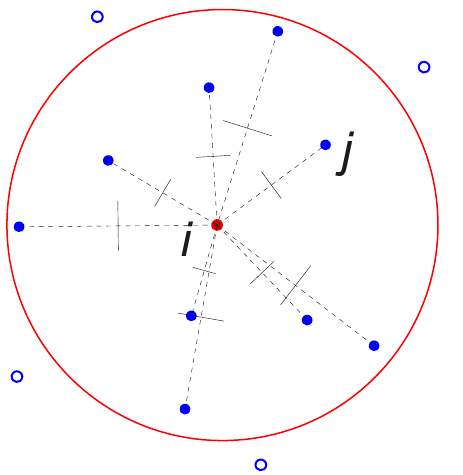
Figure 2. Stencil for particle i . Interaction between particles i and j represented as a flux in the midpoint interface ij and one-dimensional moving Riemann problem at the